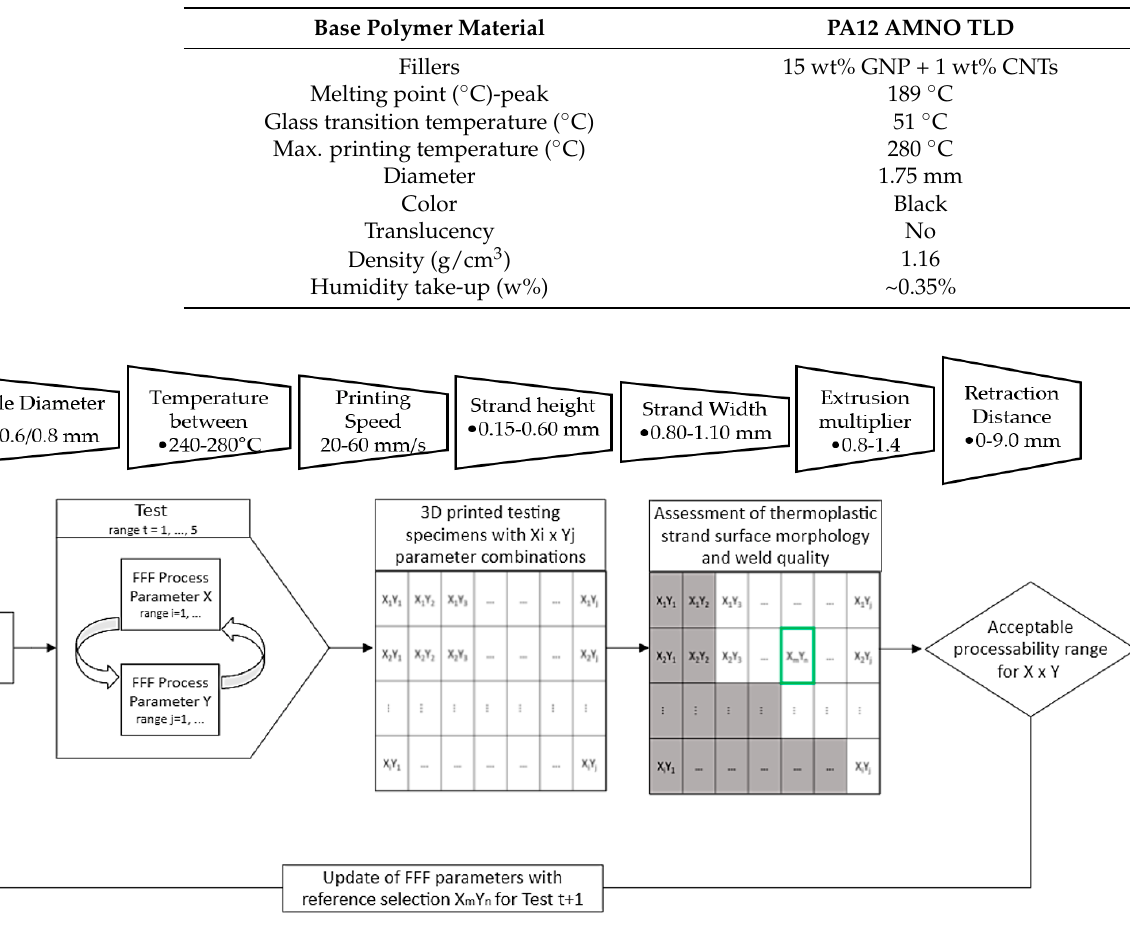
Figure 2. FFF Processability optimization path.